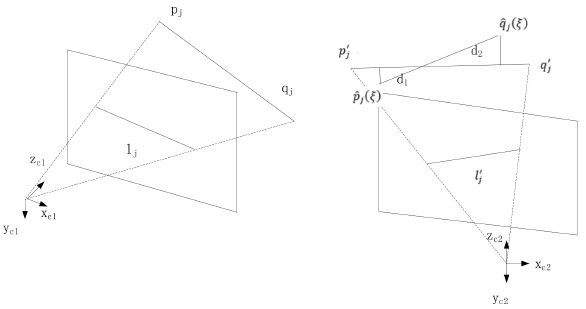
Figure 2. The re-projection error of the line